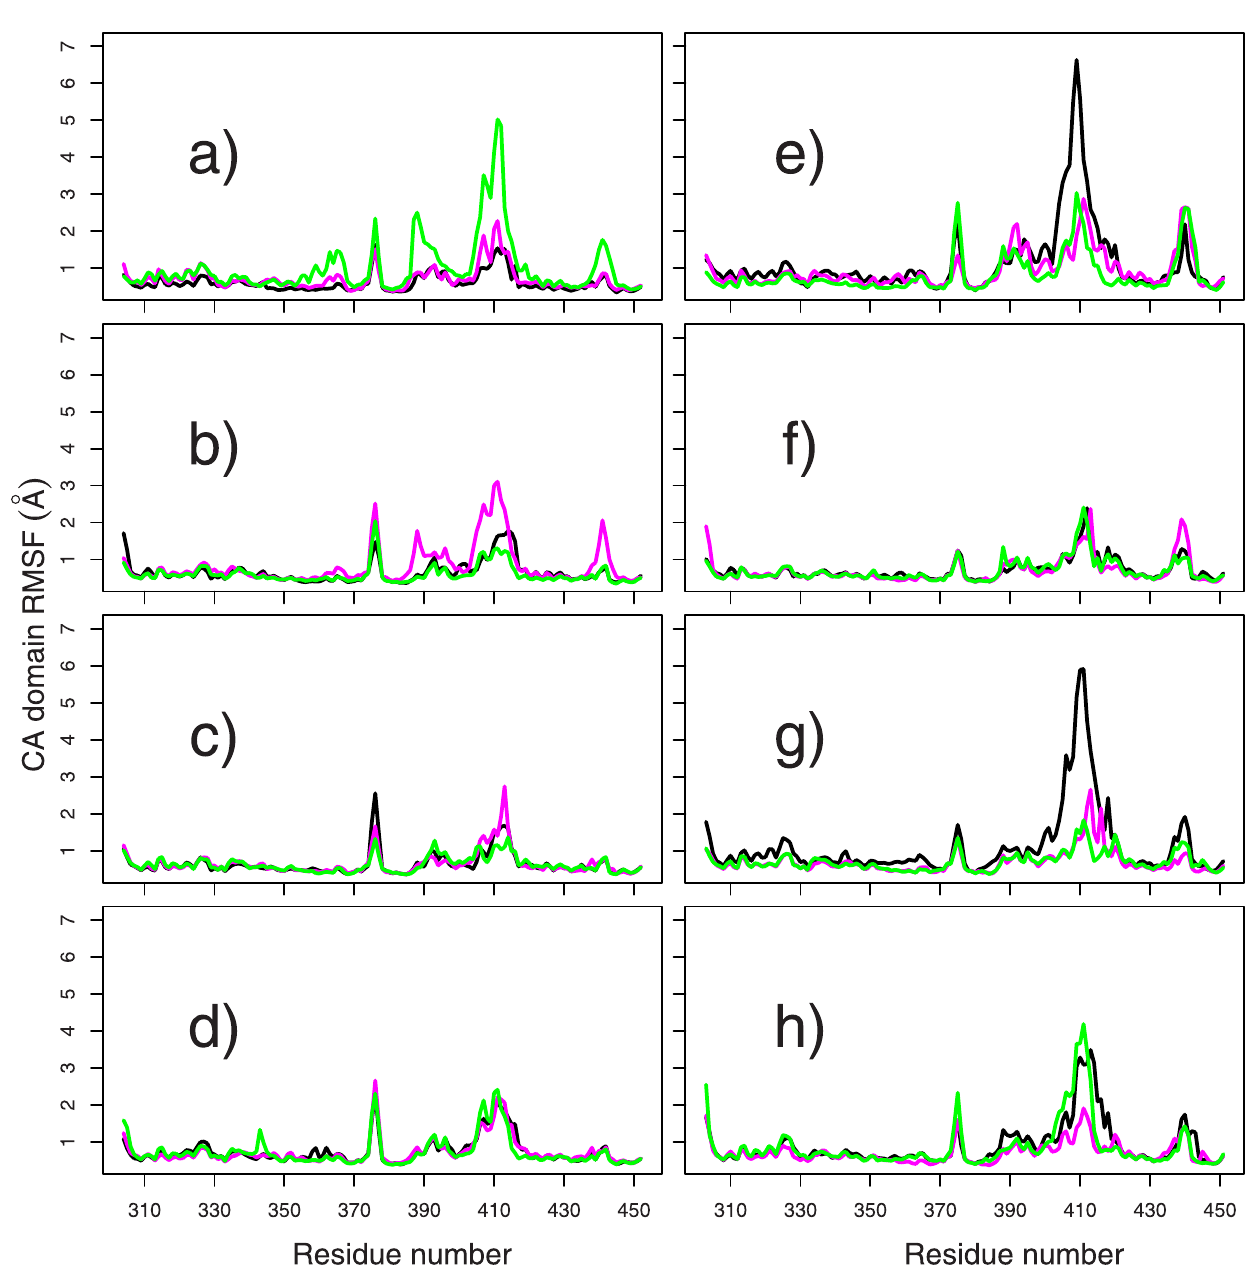
Fig 6. Atomic fluctuations by residues along the catalytic domains. Atomic fluctuations (RMSF: Å ) plotted along the CA residues for the domains CA − (a-d) and CA � (e-h). The calculations were performed on the replicas of trajectories: MD (a,d), dbl15 (b,e), mid15 (c,f) and tet20 (d,h), and the curves are drawn in the same colors than in Fig